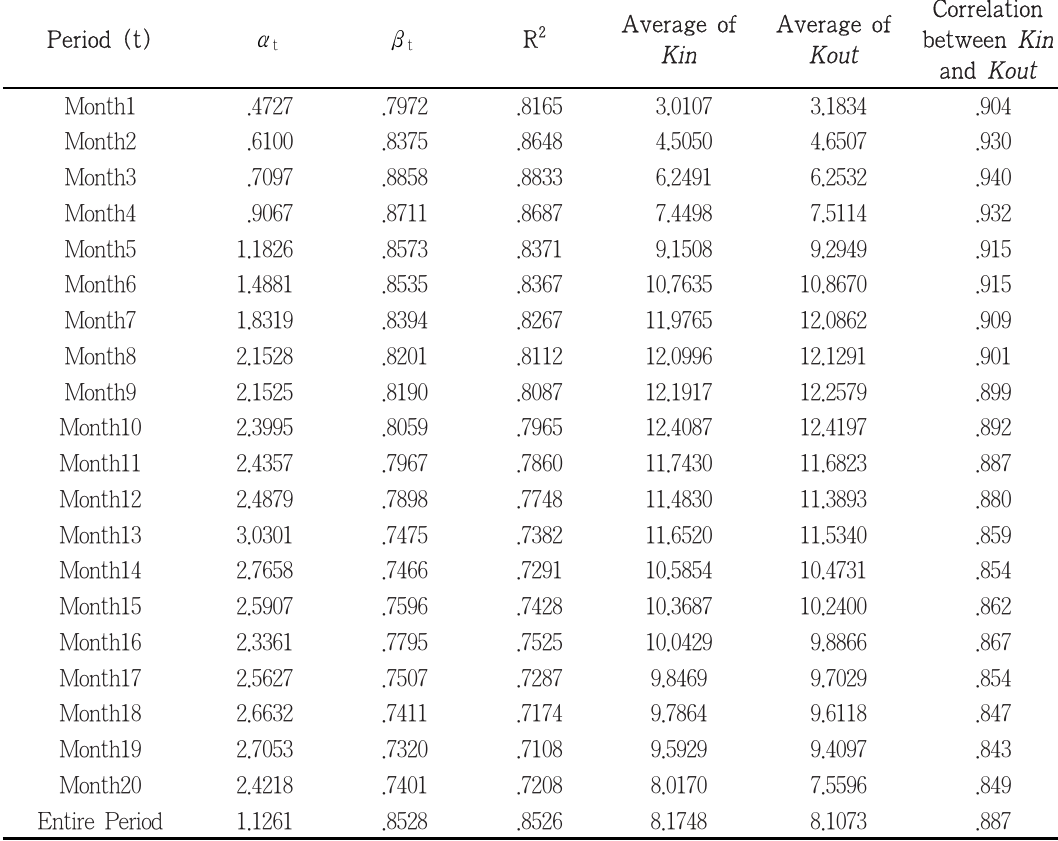
<Table 4> Regression analysis of Kin on Kout for all